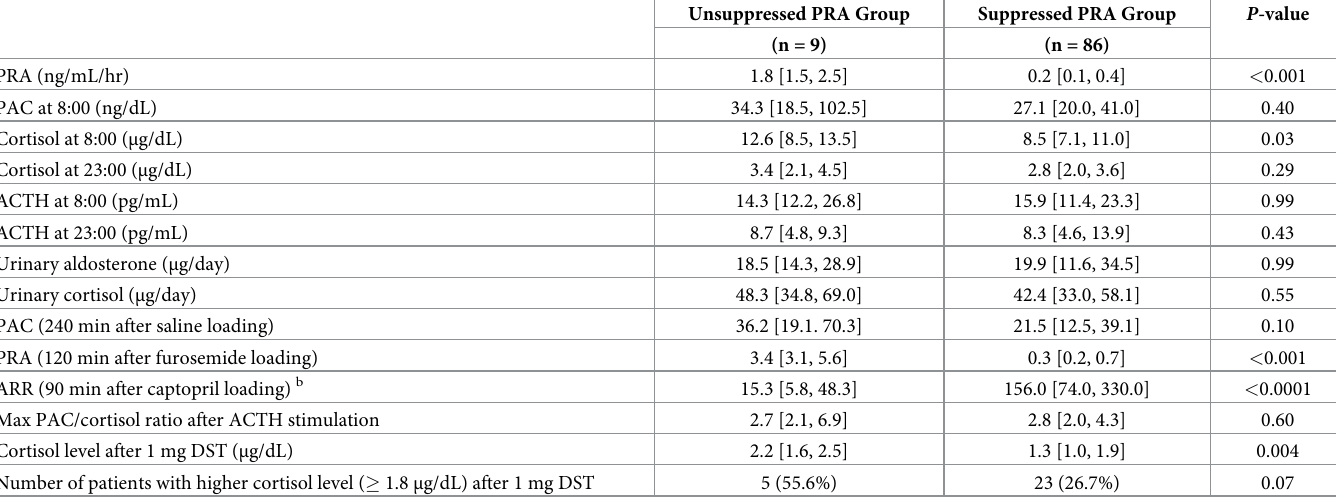
Table 2. Comparison of endocrine parameters in the unsuppressed and suppressed PRA groups a .